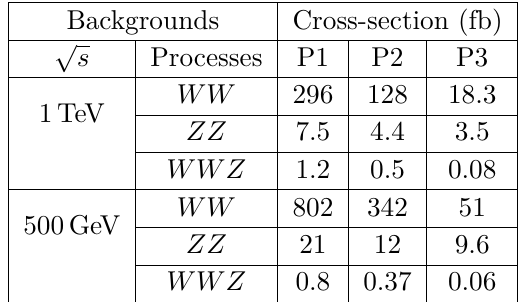
) and FDM ( σ ) are φ + φ − ψ + ψ − : − 0 . 8 , P : +0 . 3 } , P2 e + e −